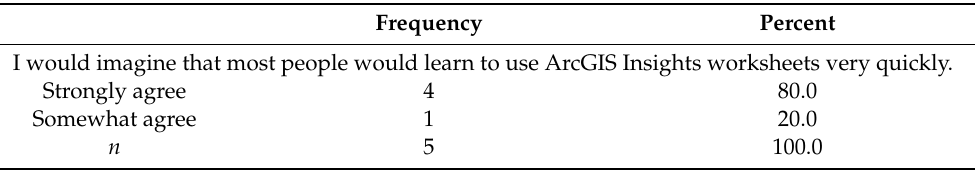
Table 9. Percentages and Frequencies,